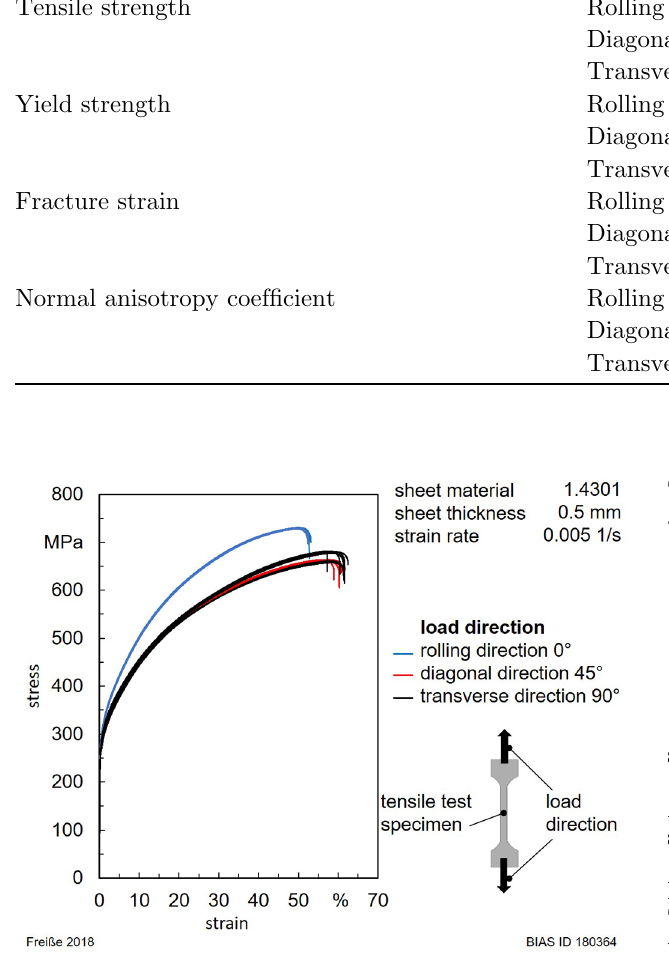
Fig. 1. Stress – strain diagram of the sheet